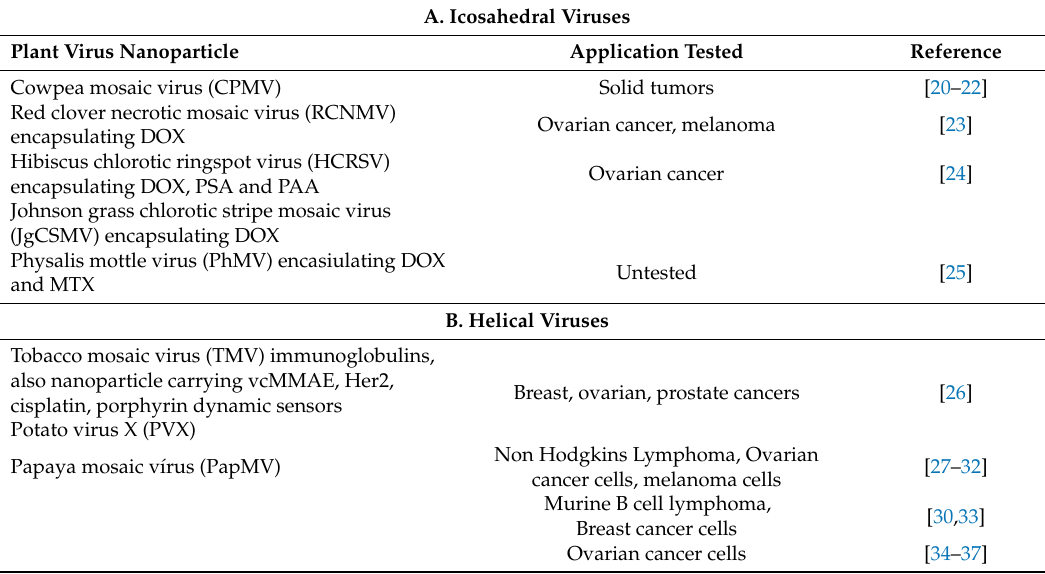
Table 1. Select examples of applications for plant virus